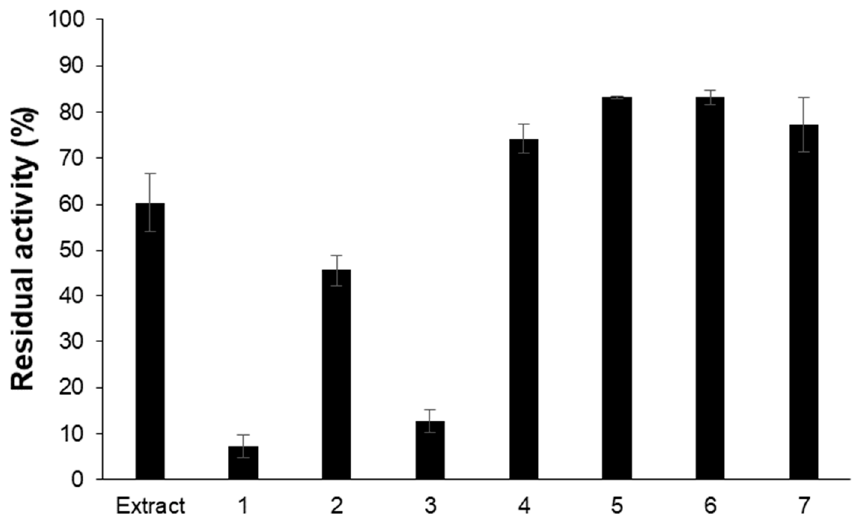
Figure 1. hMAO-A residual activity of seven spots of PTLC of ELF68 extract. The activity was measured at a concentration of 20 µg/mL of each spot.